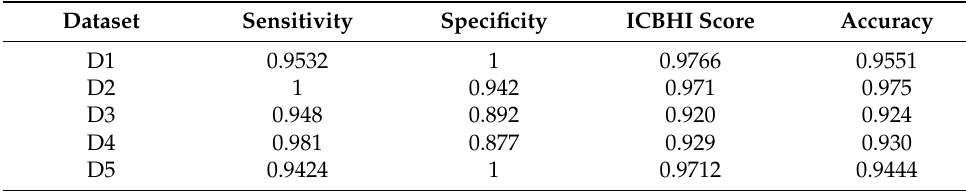
Table 24. Ensemble results for the five test